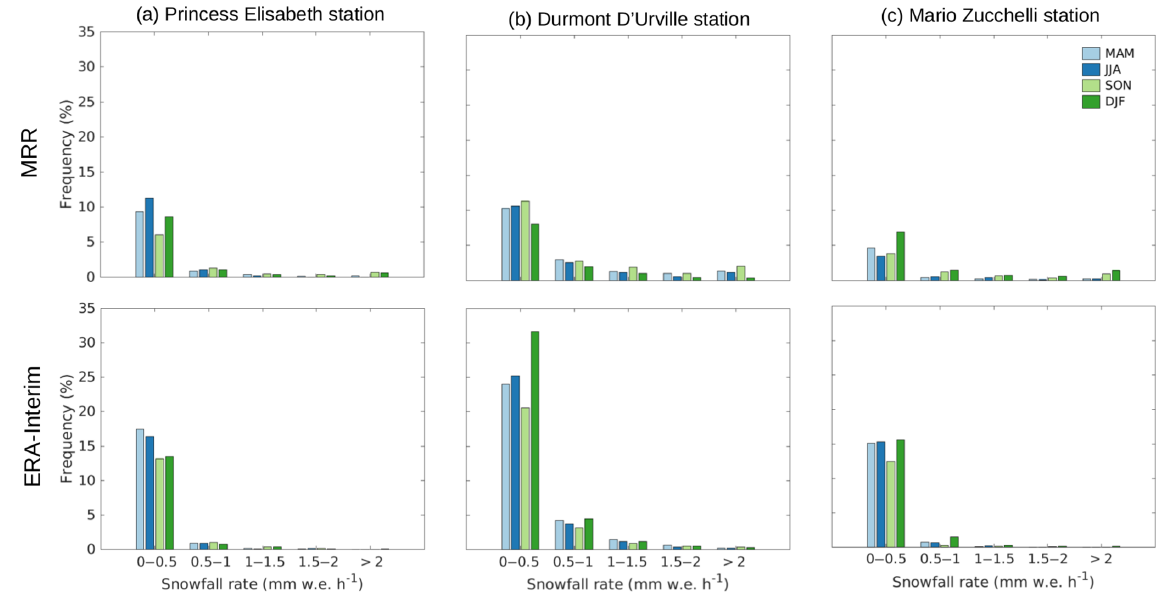
Figure 4. Seasonal variability of snowfall amounts derived from the MRRs (a) and ERA-Interim (b) at the three stations. MRR measurements denoted in purple and orange in Fig. 2 are included.